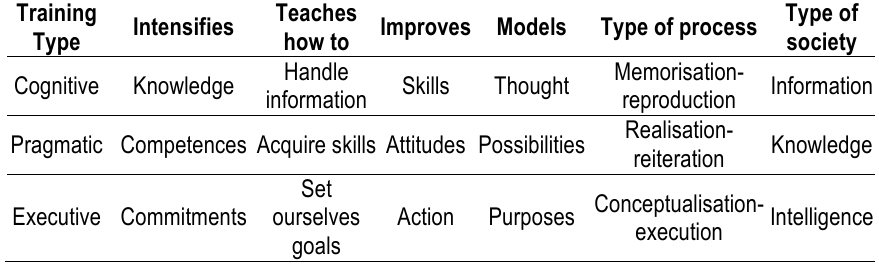
Table 1 . Educational university: types of